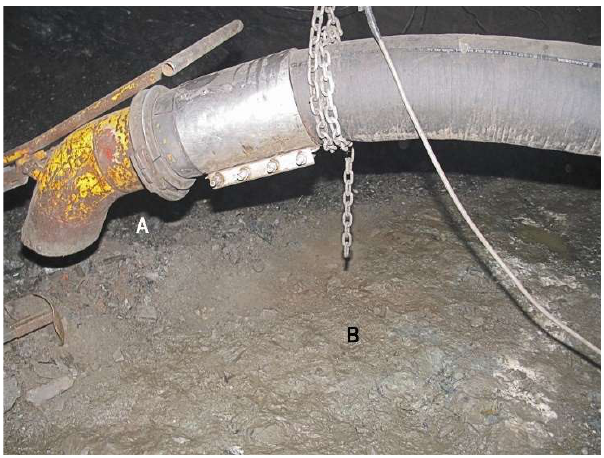
Figure 4. Approximately 0.3 m broken ore left on the drive floor before ( A ) and after ( B ) vacuuming. Supersucker hose diameter 200 mm.